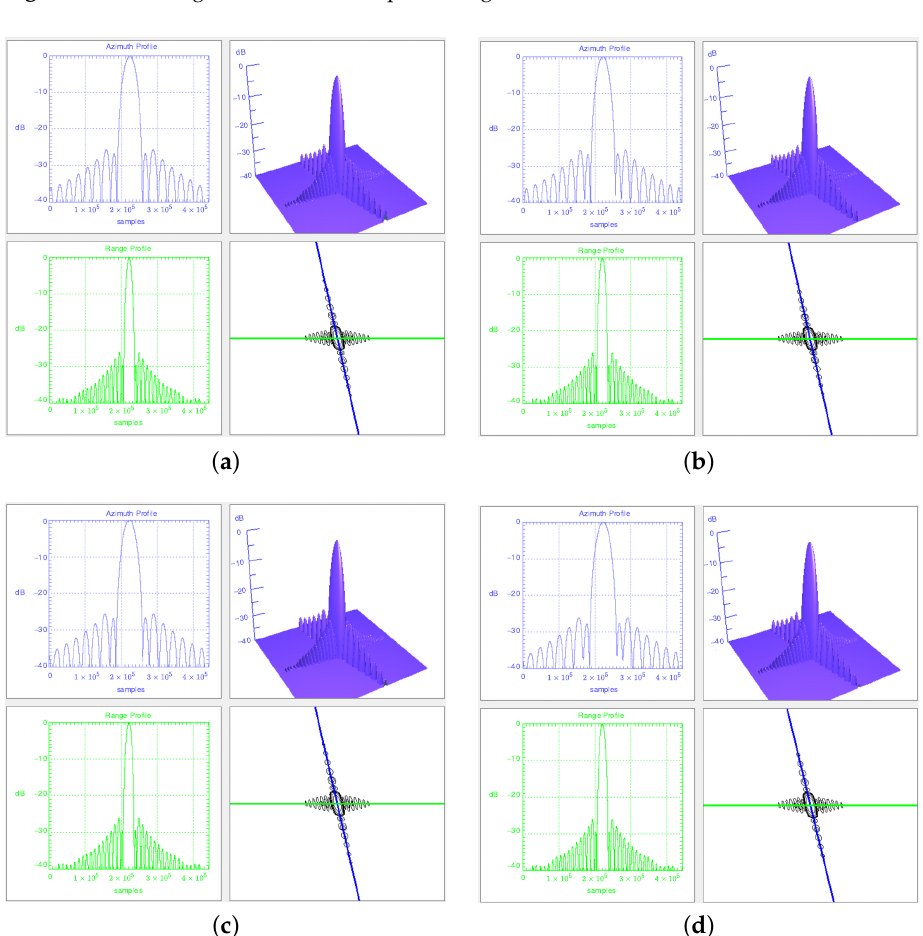
Figure 7. Partial imaging results of point targets at different positions in the scene. ( a ) Target located at the scene center. ( b ) Target at 0 m in azimuth and 4500 m in range. ( c ) Target at 0 m in azimuth and − 4500 m in range. ( d ) Target at − 4500 m in azimuth and − 4500 m in